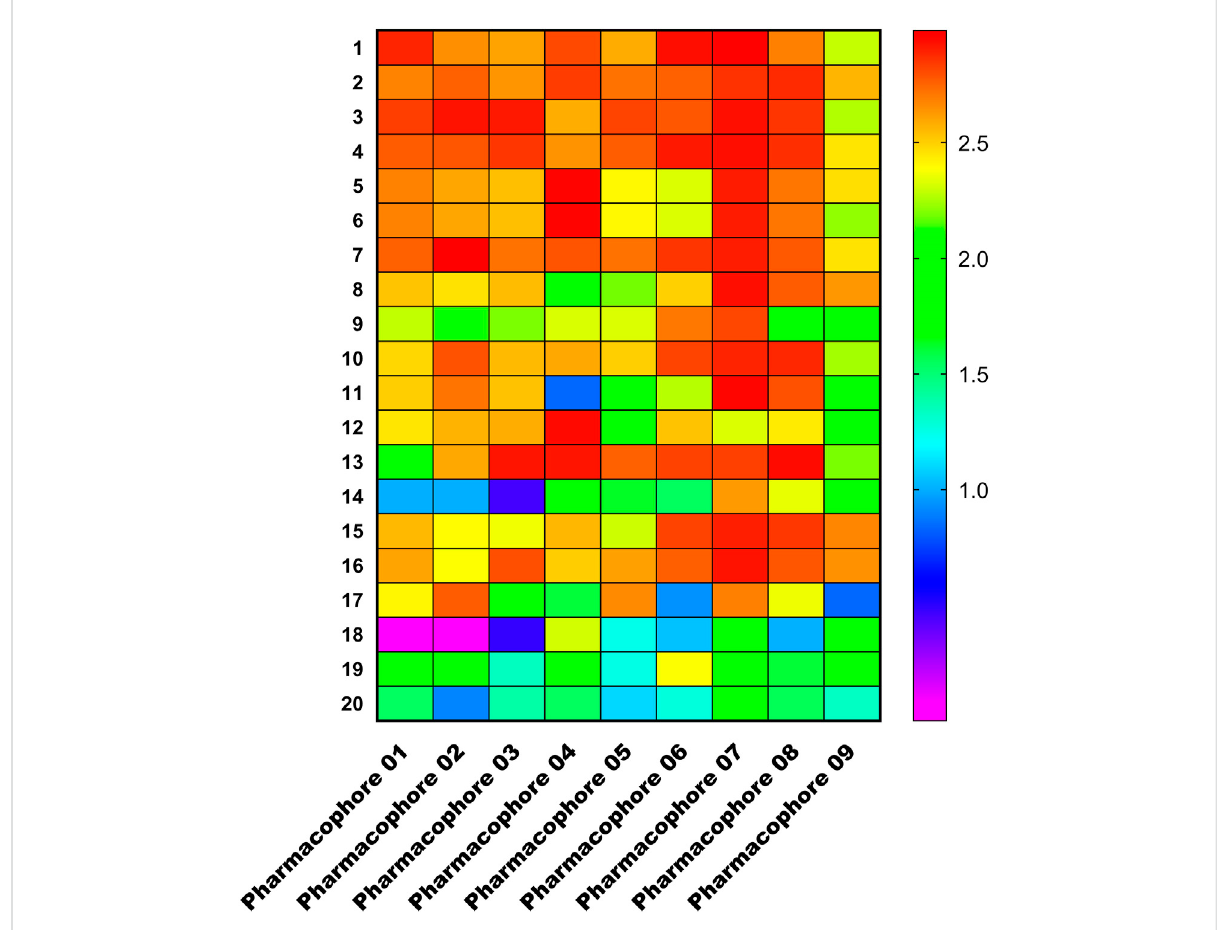
FIGURE 7 Heat map of the training set compounds predicted by the nine pharmacophore